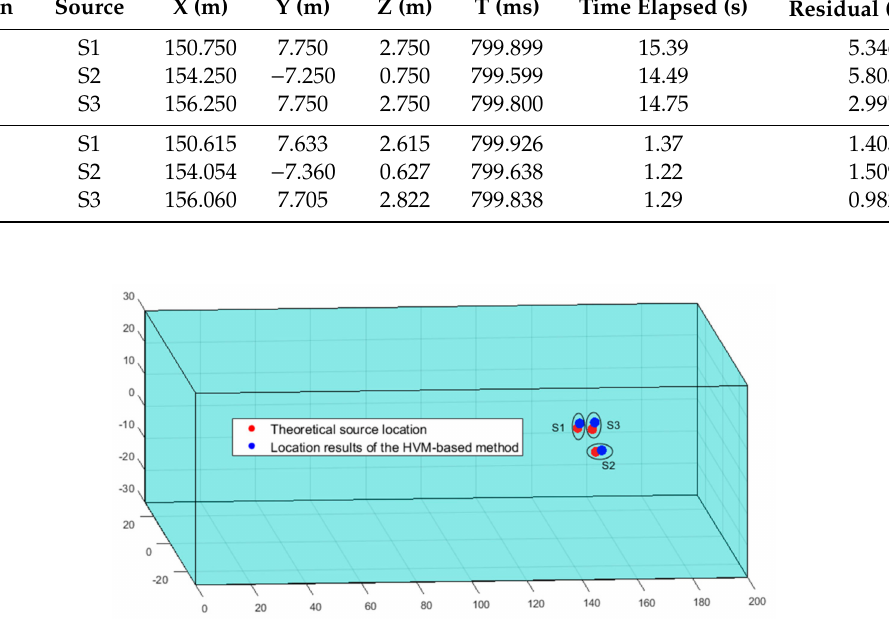
Figure 5. The results of the heterogeneous velocity model (HVM)-based method and theoretical source locations.